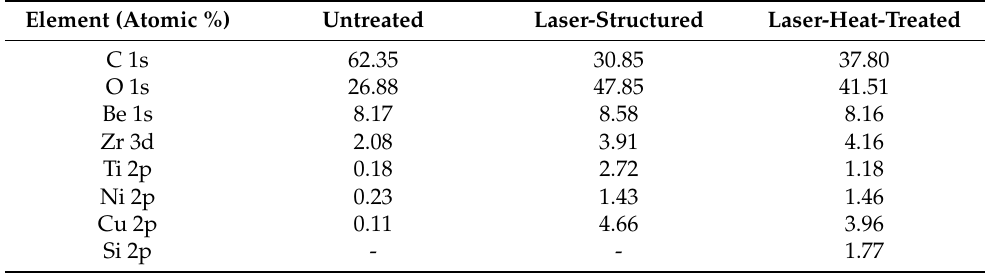
Figure 5. XPS full spectra of ( a ) untreated BMG surface; ( b ) laser-structured BMG surface; ( c ) laser- heat-treated BMG surface.